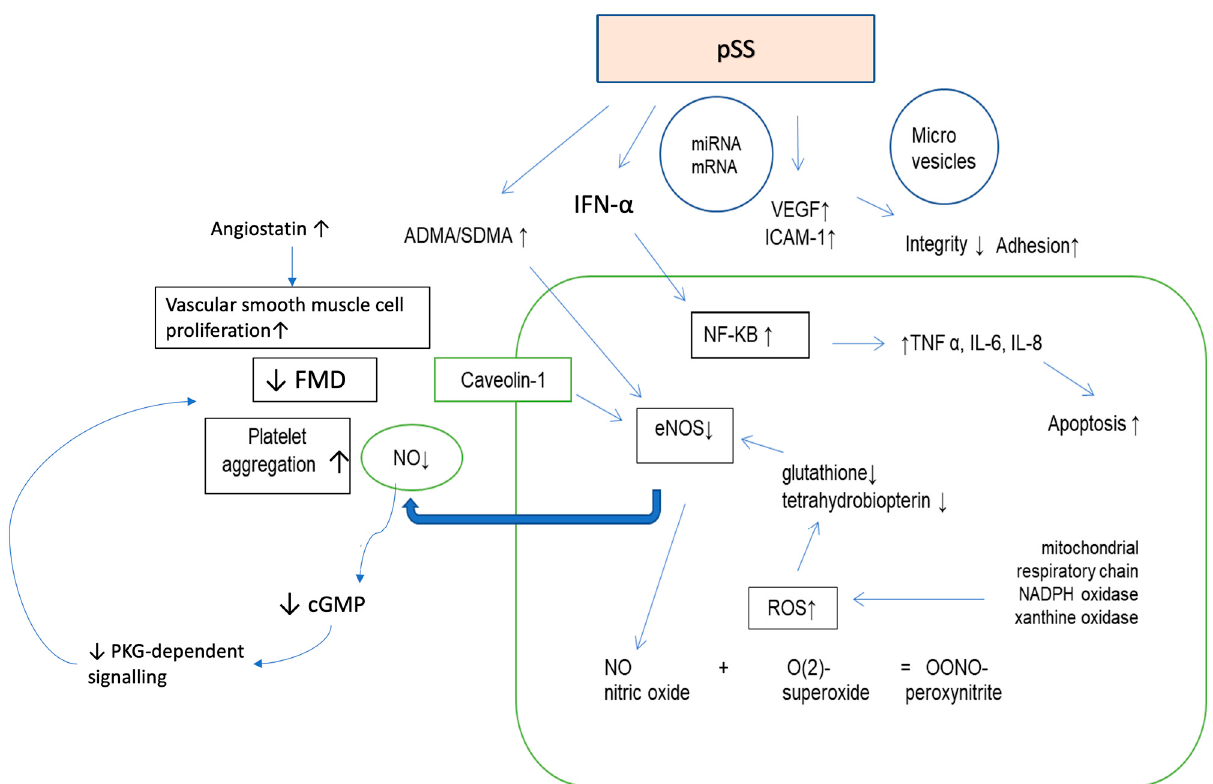
Figure 3. Changes in the profile of endothelial function in the primary Sjogren syndrome. Abbreviations: VEGF: vascular endothelial growth factor; ICAM-1: intercellular adhesion molecule 1; IFN- α : interferone alpha; NF- κ B: nuclear factor kappa-light-chain-enhancer of activated B cells; TNF α : tumor necrosis factor alpha; IL-6: interleukin 6; IL-8: interleukin 8; SDMA: symmetric dimethylarginine; ADMA: asymmetric dimethylarginine; ROS: reactive oxygen species; eNOS: endothelial nitric oxide synthase; ONOO-: peroxynitrite; NO: nitric oxide; FMD—flow-mediated dilation; cGMP—cyclic guanyl monophosphate; O(2)-: superoxide anion; PKG—protein kinase G; pSS: primary Sjogren syndrome, ↑ : increased; ↓ : decreased.